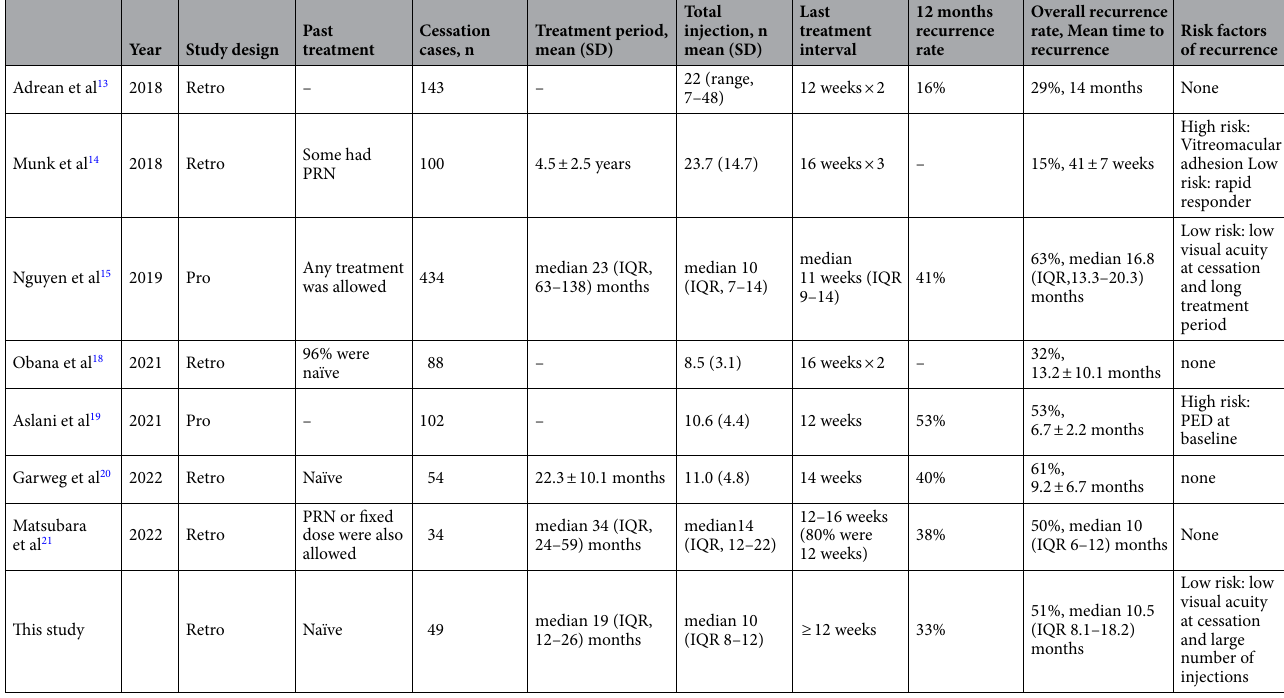
Table 4. Summary of previous reports on recurrence after cessation of treat and extend regimen in patients with neovascular age-related macular degeneration. IQR, interquartile range; PED, pigment epithelial detachment; PRN, pro re nata; SD, standard